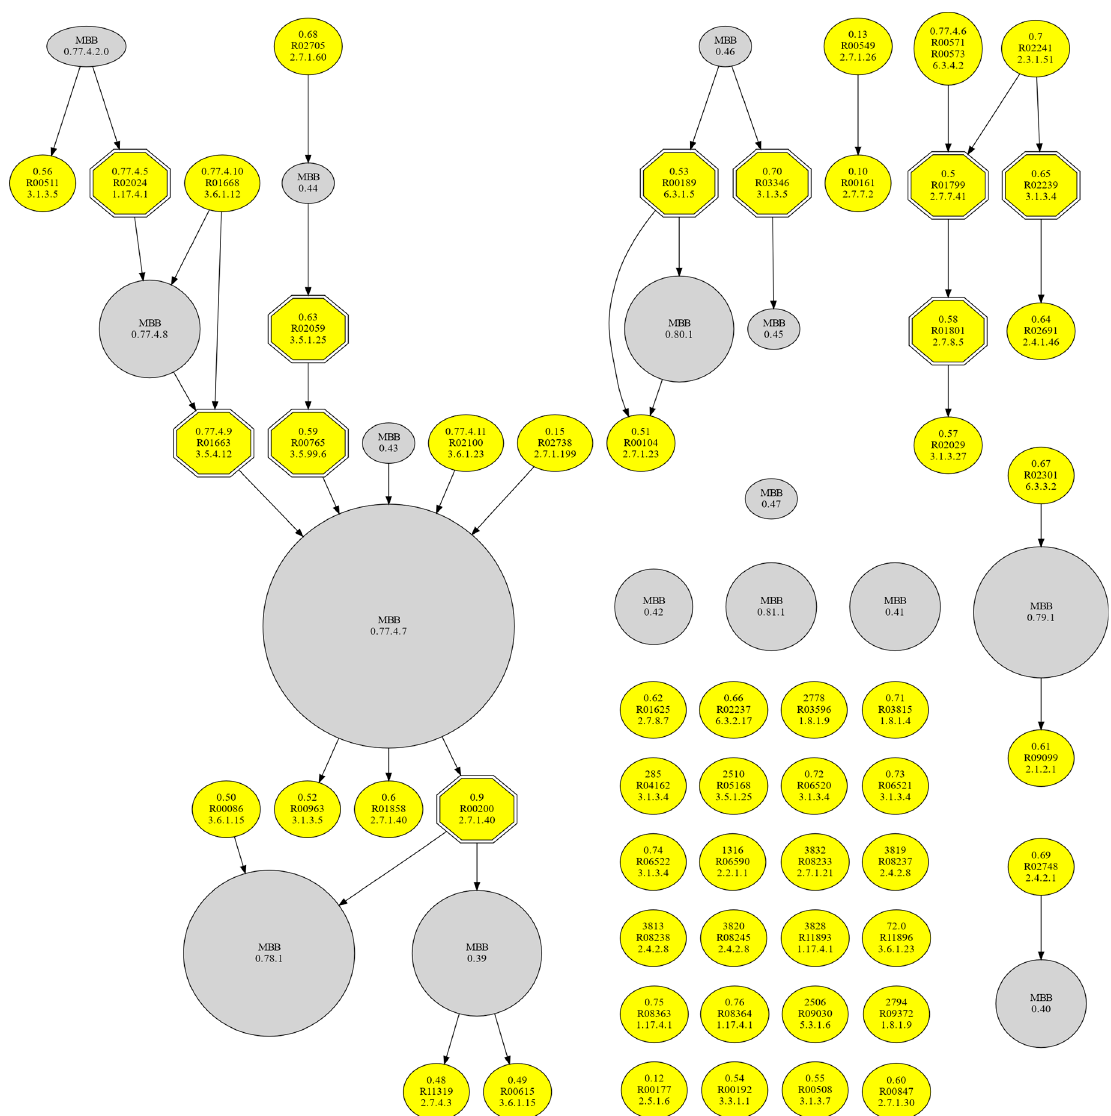
Figure 4. m ‐ DAG of the metabolism of JCVI ‐ syn3.0. Single reactions appear in yellow, contracted MBBs in grey, and the Figure 4. m-DAG of the metabolism of JCVI-syn3.0. Single reactions appear in yellow, contracted MBBs in grey, and the essential reactions as hexagons with double lines . essential reactions as hexagons with double